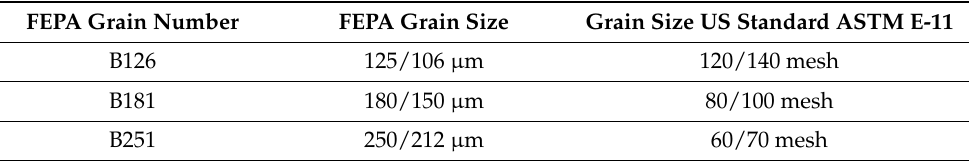
Table 3. Summary of designations and dimensions of characteristic abrasive micrograins according to various industry standards [17].